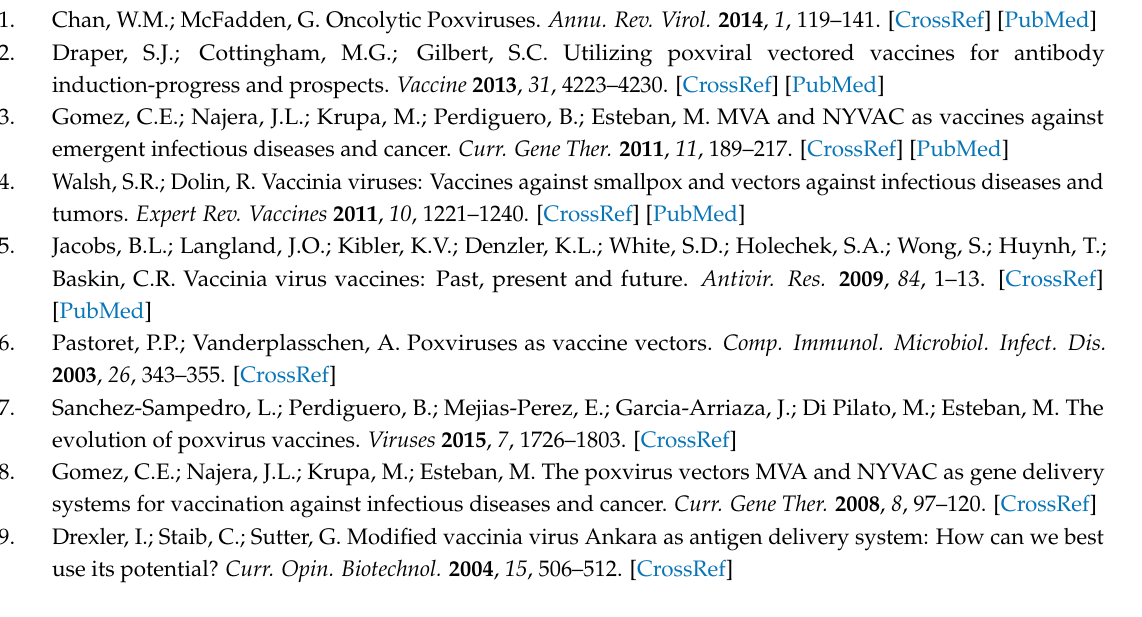
Figure S1: Construction of plasmid pD12-mCherry, Figure S2: DNA sequence comparison of loci AT and D of the ORFV D1701 variants, Figure S3: Amino acid comparison of ORF117 (GIF) of different ORFV strains, Figure S4: Nucleotide sequence comparison of the core motifs of different poxviral early